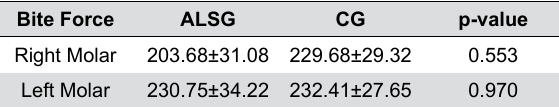
Table 5- Comparison of the mean bite force (N) according to the groups. ALSG: Amyotrophic lateral sclerosis group; CG: control group; SD: standard deviation; RM: right masseter; LM: left masseter; RT: right temporal; LT: left temporal. Statistical significance was calculated using t test